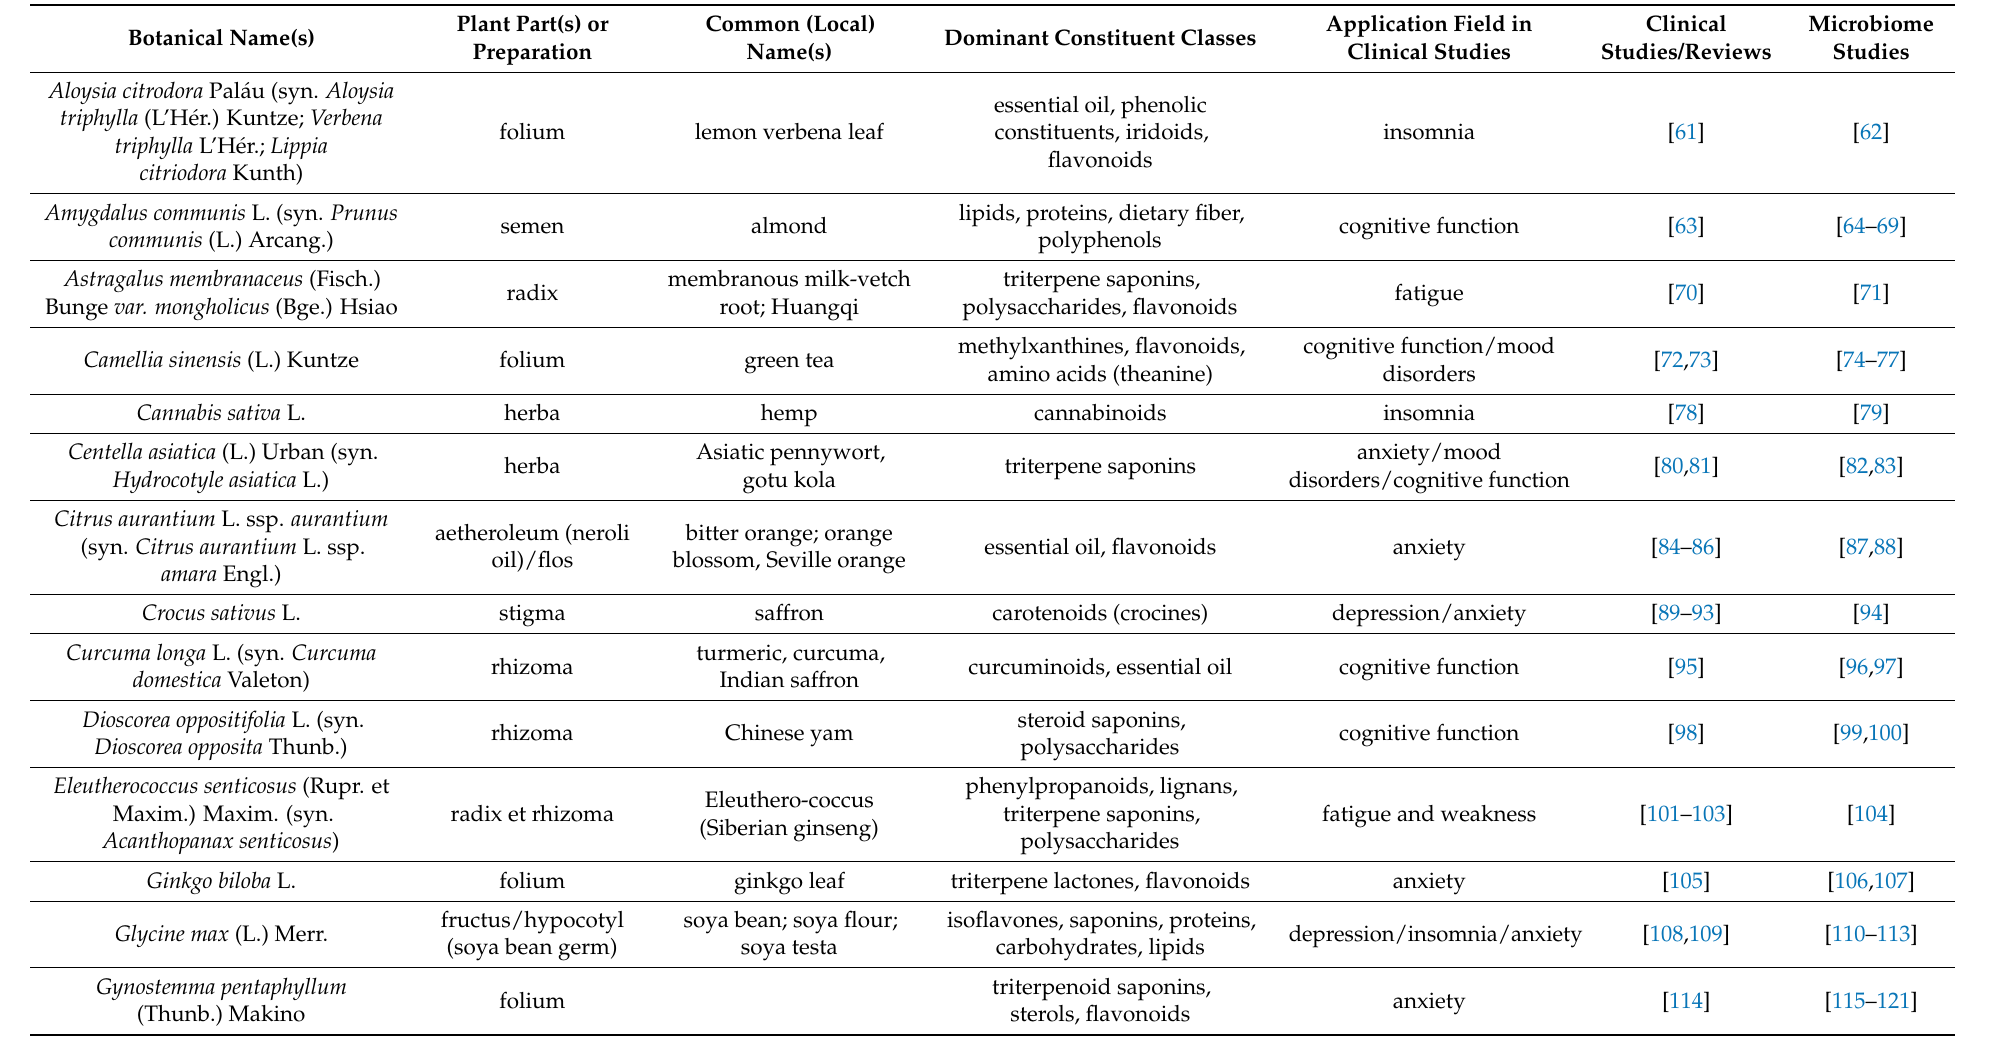
Table 1. Randomized controlled trials and studies of herb–gut microbiome interactions of medicinal plants used in neuropsychiatric